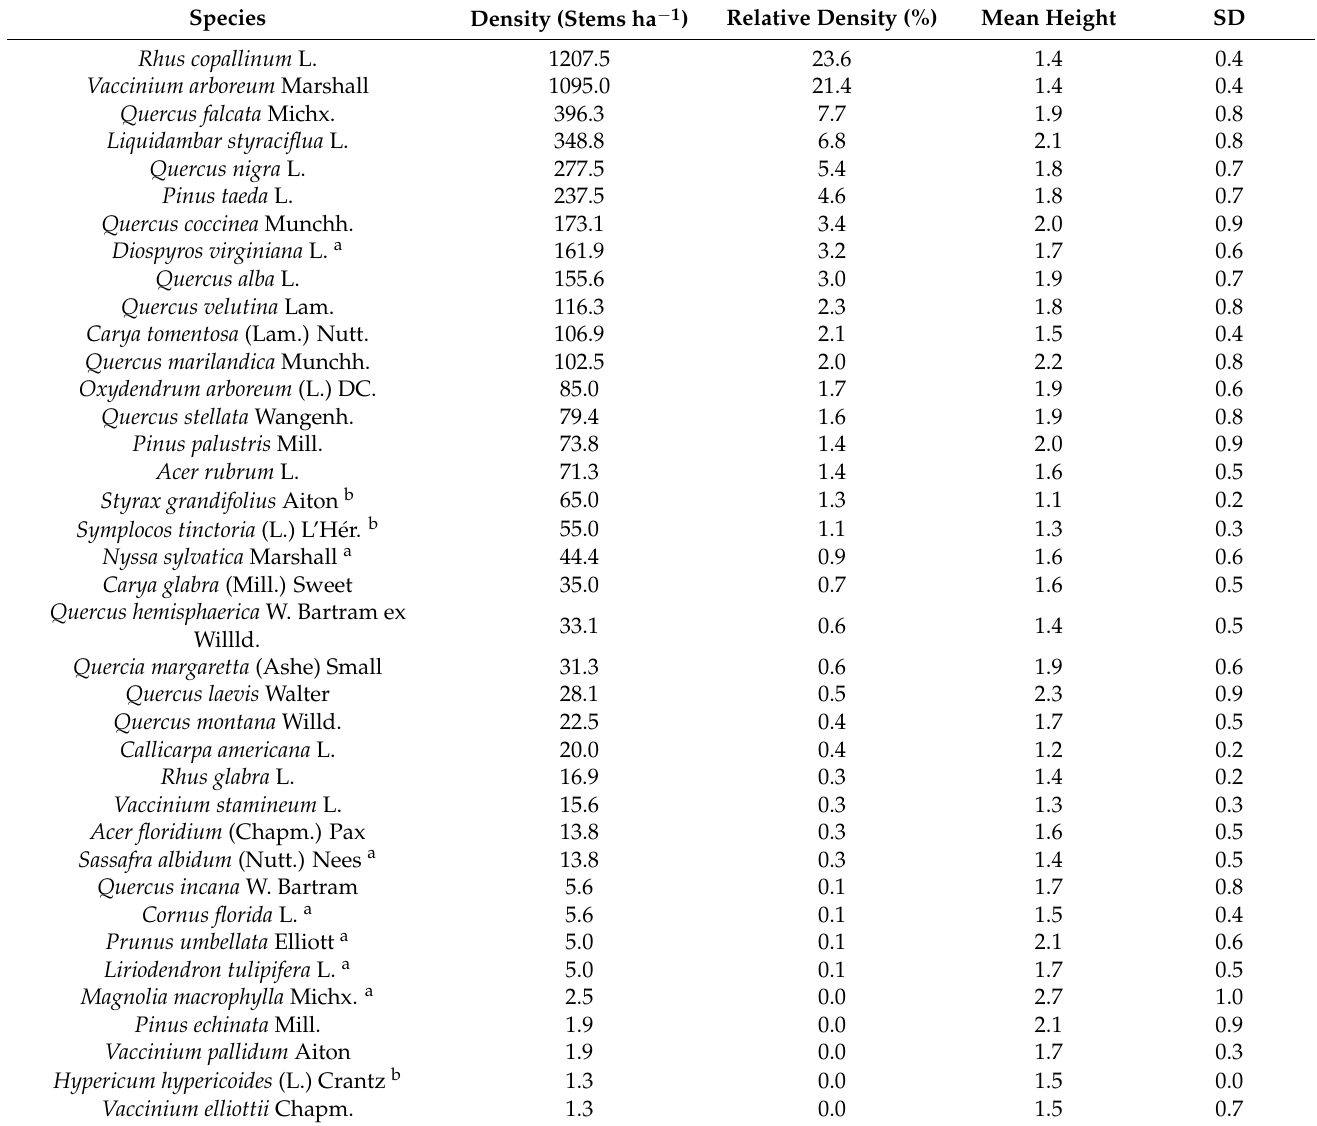
Table 2. Density (stems ha − 1 ) and relative density (% of contribution), mean height, and standard deviation of mean height (SD) of saplings (live, woody stems <5 cm dbh, ≥ 1 m height) documented in a catastrophically disturbed Pinus palustris woodland on the Oakmulgee Ranger District, Talladega National Forest, Alabama, USA. Species are ranked by relative density. Species with letters were placed into a hardwood and b shrub taxonomic groups used for height comparison. Species Density (Stems ha − 1 ) Relative Density (%) Mean Height